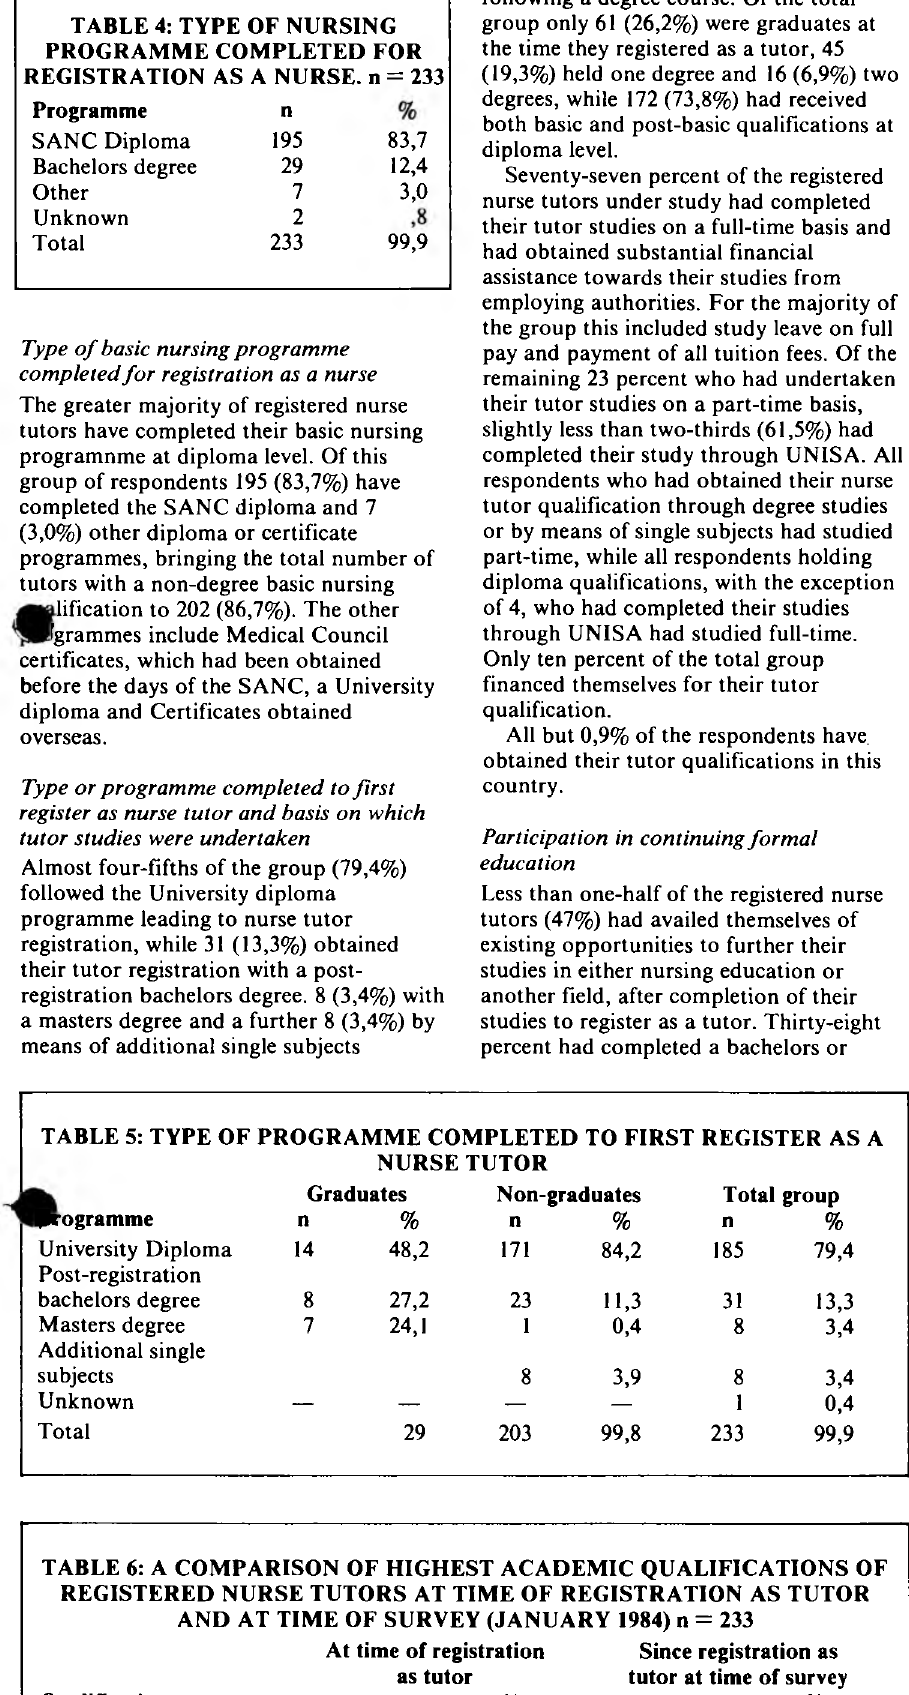
TABLE 6: A COMPARISON OF HIGHEST ACADEMIC QUALIFICATIONS OF REGISTERED NURSE TUTORS AT TIME OF REGISTRATION AS TUTOR AND AT TIME OF SURVEY (JANUARY 1984) n =